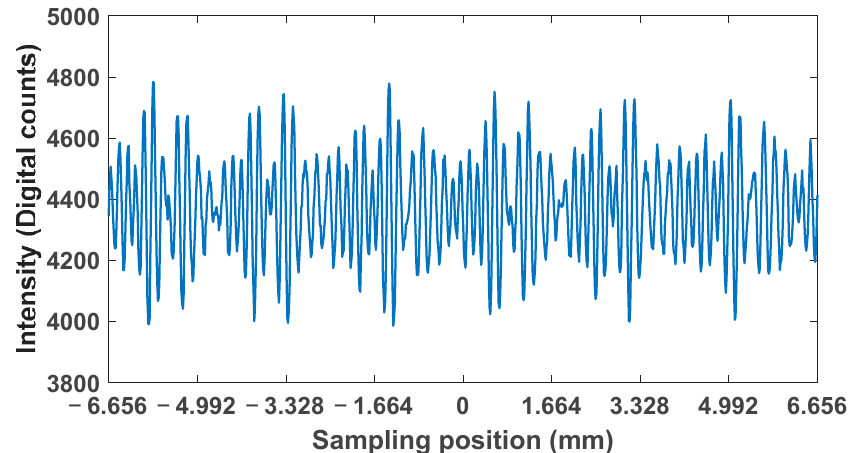
Figure 8. Single-FOV simulation interferogram.